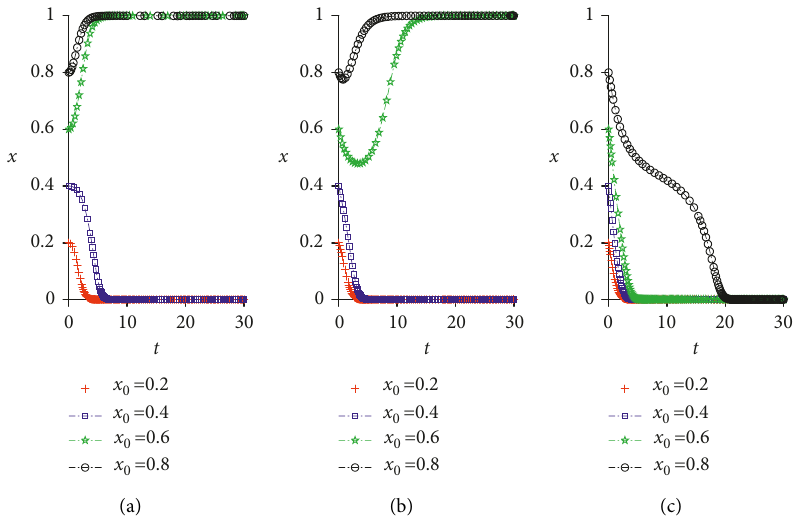
Figure 8: Impact of α on system evolution. Comparing (a), (b), and (c), as α (service provider’s spillover coefficient) decreases, the probability of the system evolving to the ideal state increases. (a) α